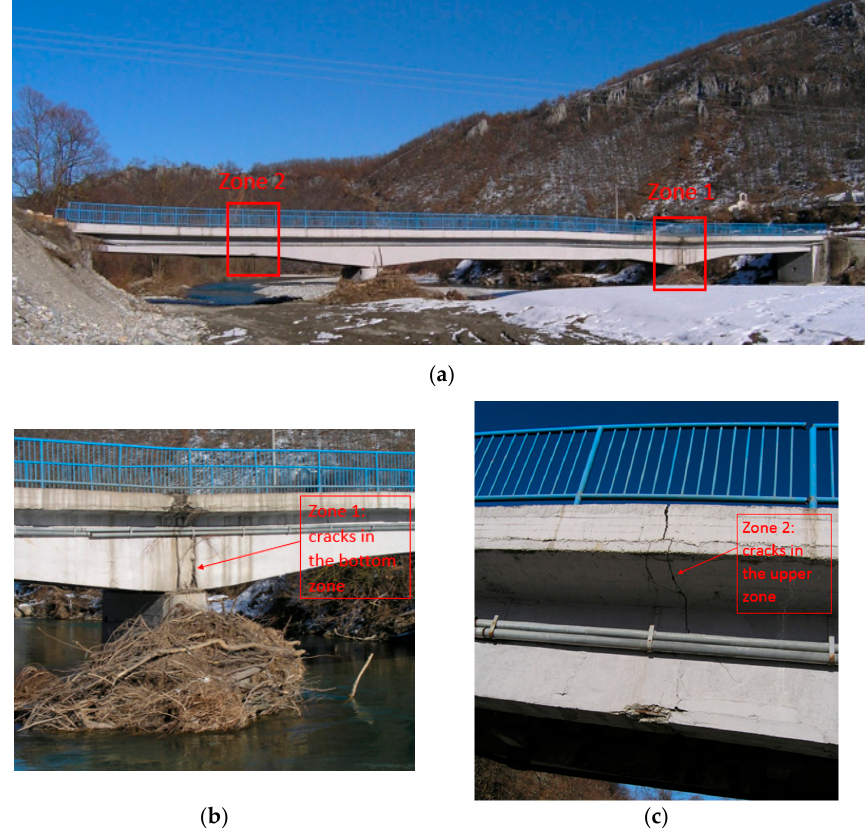
Figure 16. ( a ) The bridge after the settlement of the river pier, ( b ) cracks in zone 1, and ( c ) cracks in zone 2.